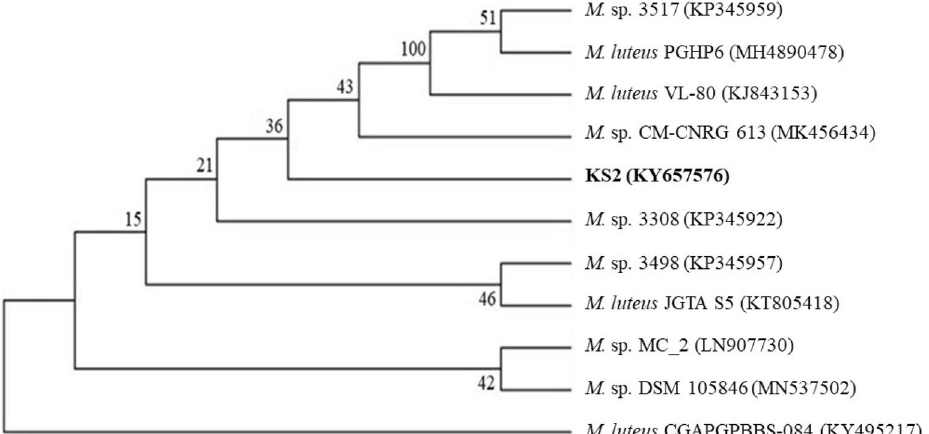
Figure 1. Phylogenetic tree obtained for strain